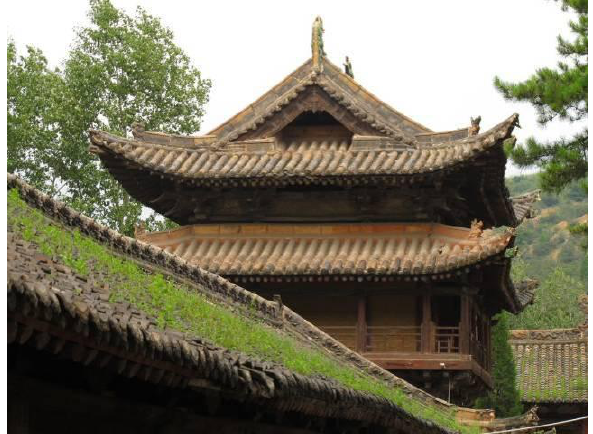
Figure 1 Xi Shu Zhuang Pavilion date to Jin Dynasty (1115- 1234A.D.) in Lingchuan County, Shanxi Province. Being renovated before